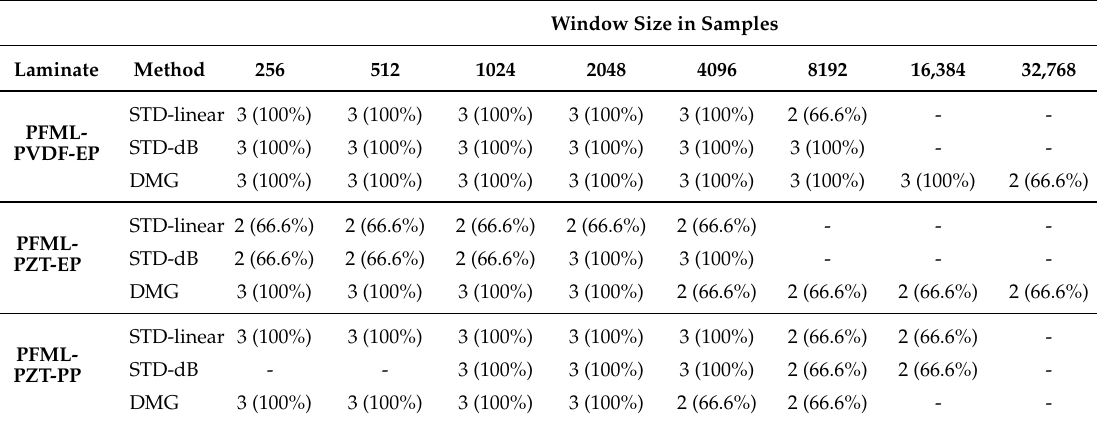
Table 2. Analysis results for complete failure detection by the standard deviation of the SED (STD) and the damage index (DMG) as a function of scaling and measurement window size for the amount of specimens (numbers in brakes show the retaliative quantity of specimens).